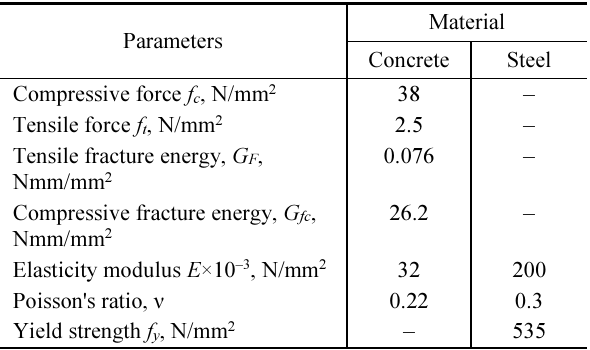
Table 4. The values of the parameters of the materials used in